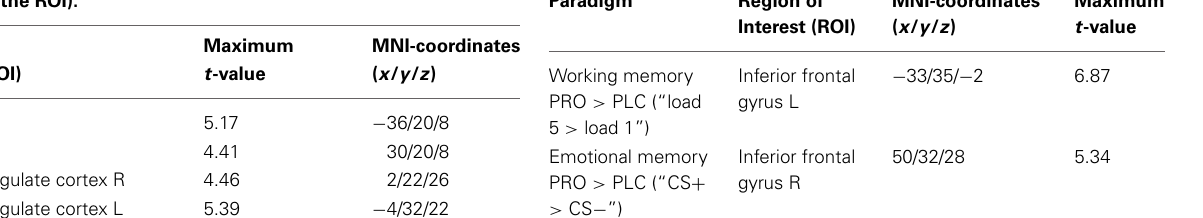
Table 6 | Significant main effect of stimulus type (“CS + > CS − ”) in the entire sample ( n = 25) thresholded at p > 0 . 05 (FWE-corrected for the size of the